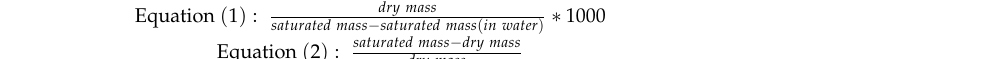
Table 4. Summary of standard codes and methods used for testing DPF concrete/mortar. Ref.